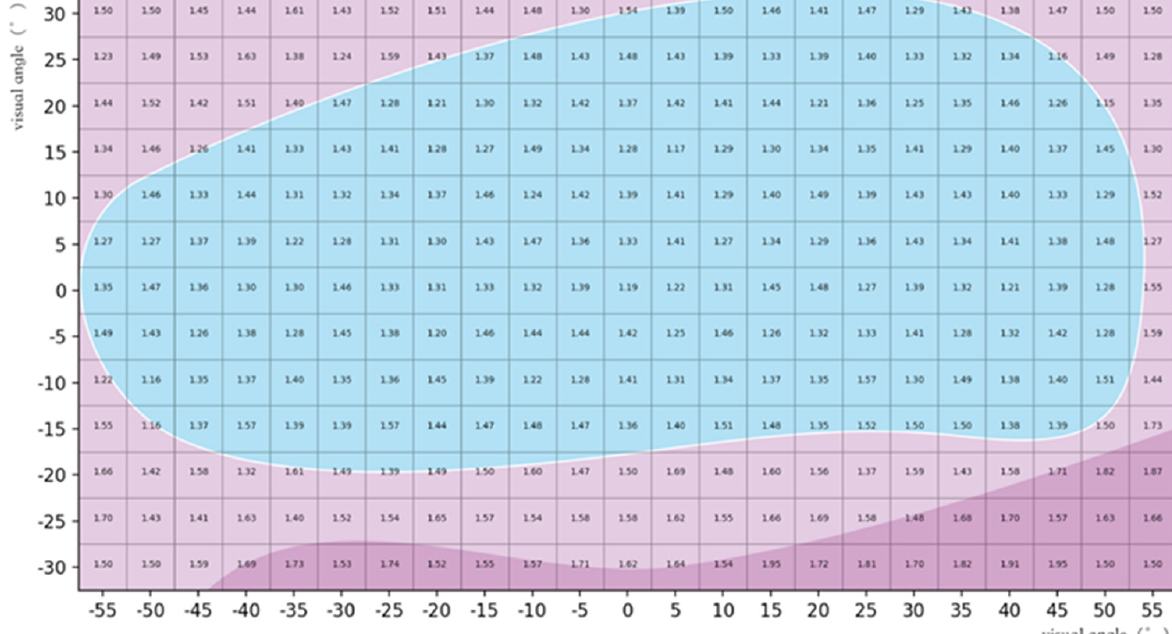
Figure 7. Contour map of click accuracy.